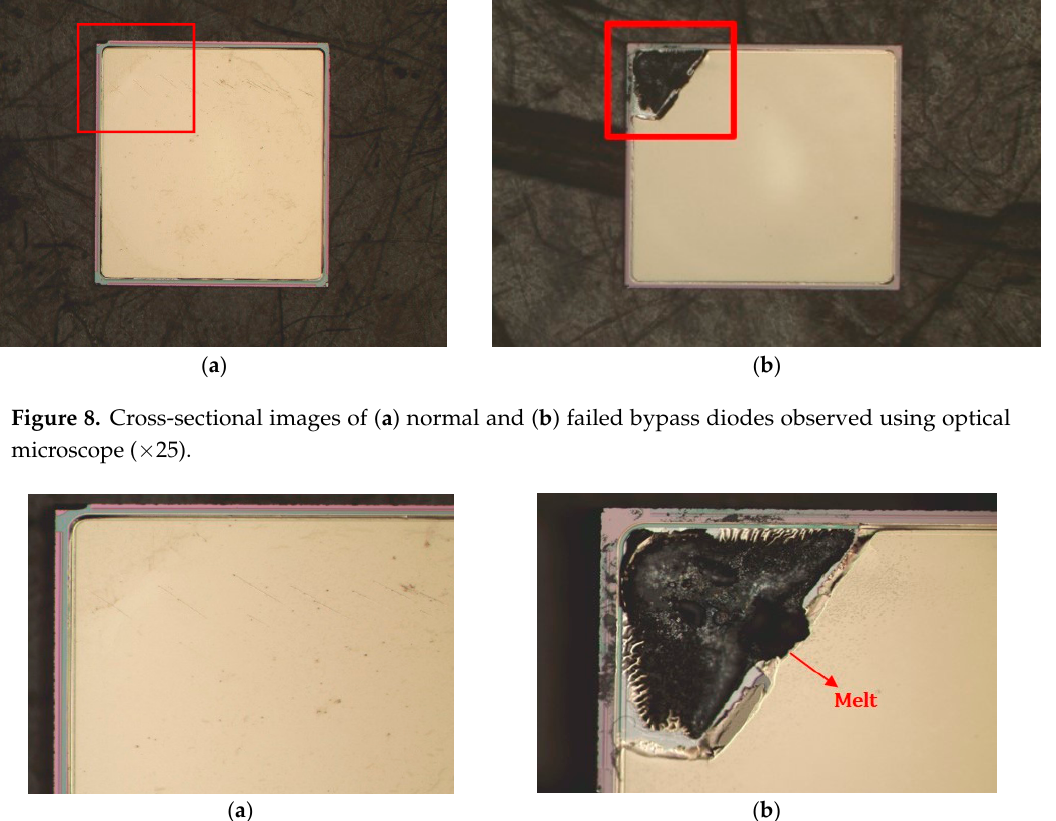
Figure 9. Magnified images (×200) of ( a ) normal and ( b ) failed bypass diode.